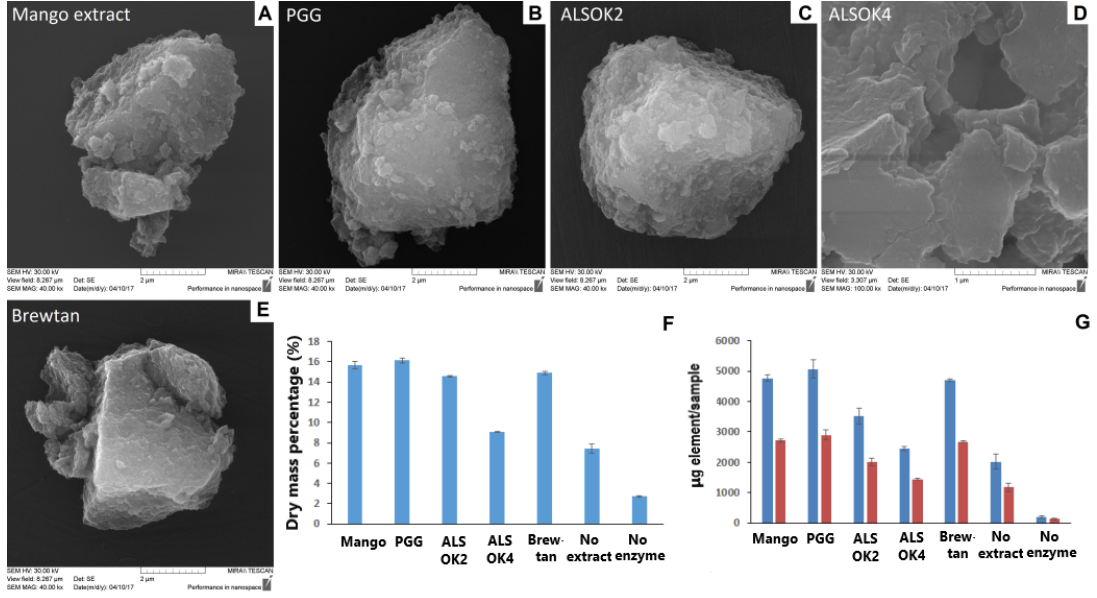
Figure 1. ( A – E ) Scanning electron microscopy (SEM) images of mineralized hydrogels containing different gallotannin preparations, ( F ) Dry mass percentage of mineralized hydrogels containing different gallotannin preparations ( n = 3). ( G ) Inductively coupled plasma optical emission spectroscopy (ICP-OES) determination of amounts of elemental Ca (blue) and P (red) in mineralized hydrogels containing different gallotannin preparations ( n = 3).